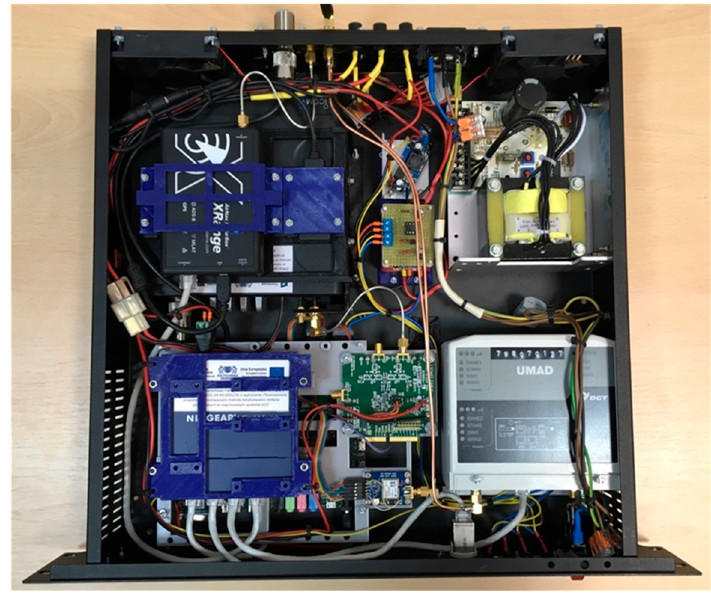
Figure 2. Interior of the radio station (RS).